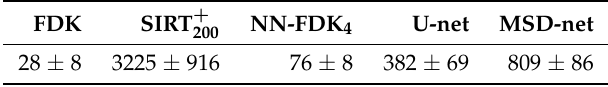
Table 3. Average and standard deviation of the reconstruction times (in seconds) computed over 120 reconstruction problems with N = 1024 and N a = 360 projection angles. These reconstructions are computed using one Nvidia GeForce GTX 1080Ti GPU (11 GB). FDK SIRT + NN-FDK 200